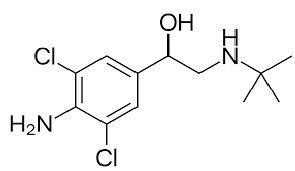
Figure 6. Chemical structure of cardarine. Formula: C 21 H 18 F 3 NO 3 S 2. Physiological effect: This is a PPAR δ receptor agonist [14]. It helps to increase fat-burning capacity.